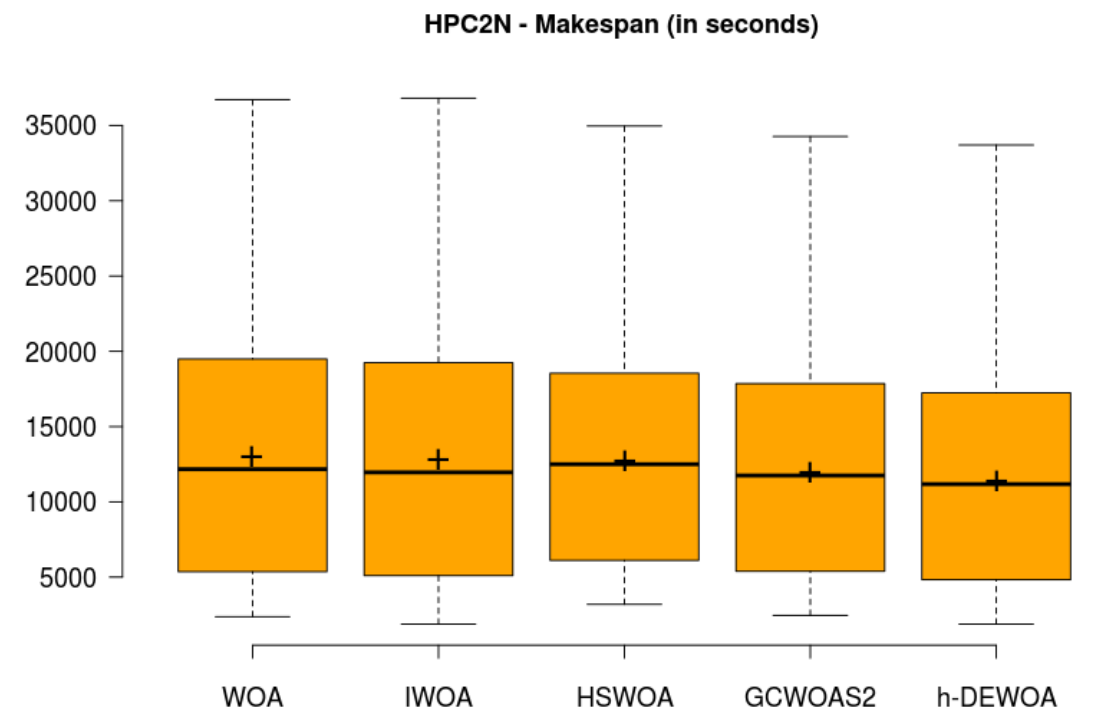
Figure 13. Comparative boxplot analysis of the overall makespan of h-DEWOA- and WOA-based scheduling algorithms for HPC2N workloads.